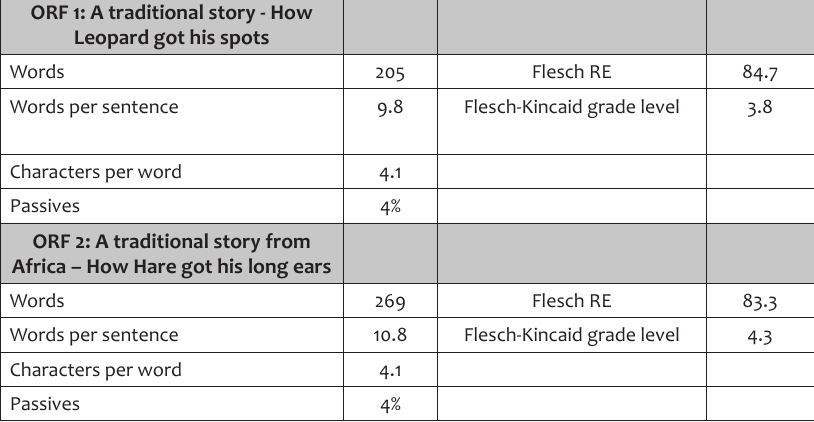
Table 6: Readability scores of passages (ORF 1 & ORF 2) ORF 1: A traditional story -